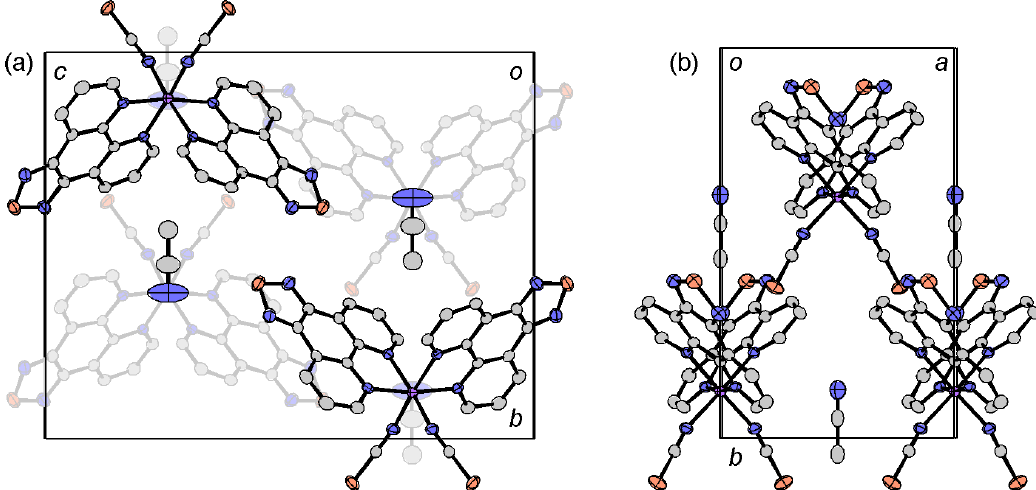
(NCS) ]•MeCN along the a (a) and c (b) axes. 2 2